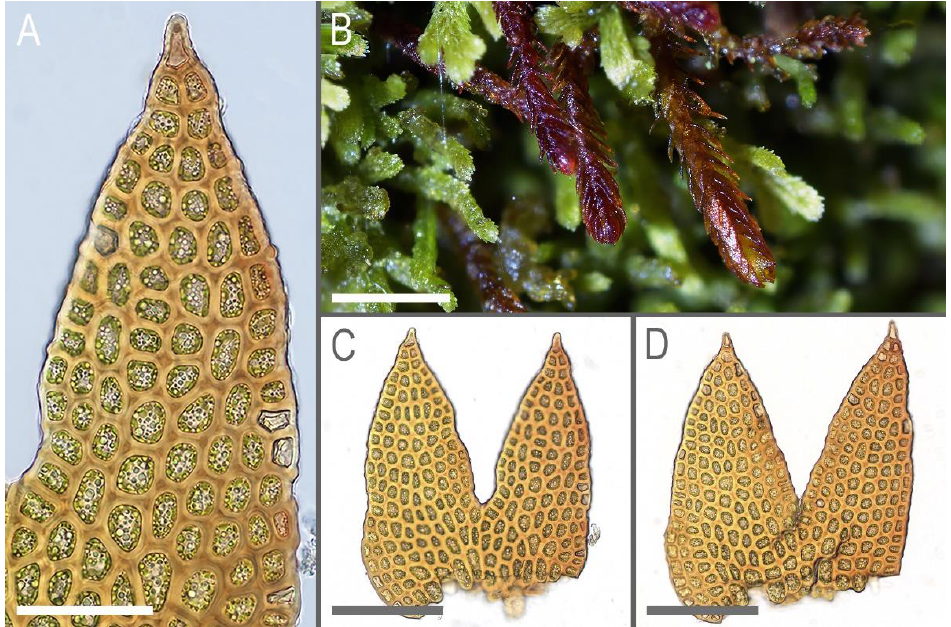
Figure 3. Marsupella anastrophylloides Bakalin, Vilnet et Maltseva sp. nov .: ( A ) leaf lobe; ( B ) plant habit; ( C , D ) leaves. Scales: 50 µm for ( A ); 1 mm for ( B ); 50 µm for ( C , D ). All from Holotype V-15-6-20 (VBGI).